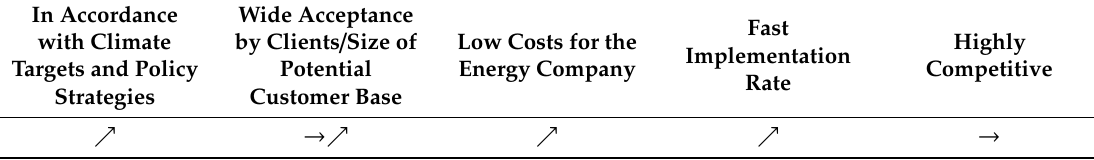
Table 7. Assessment of the smart home as a business model for energy companies.